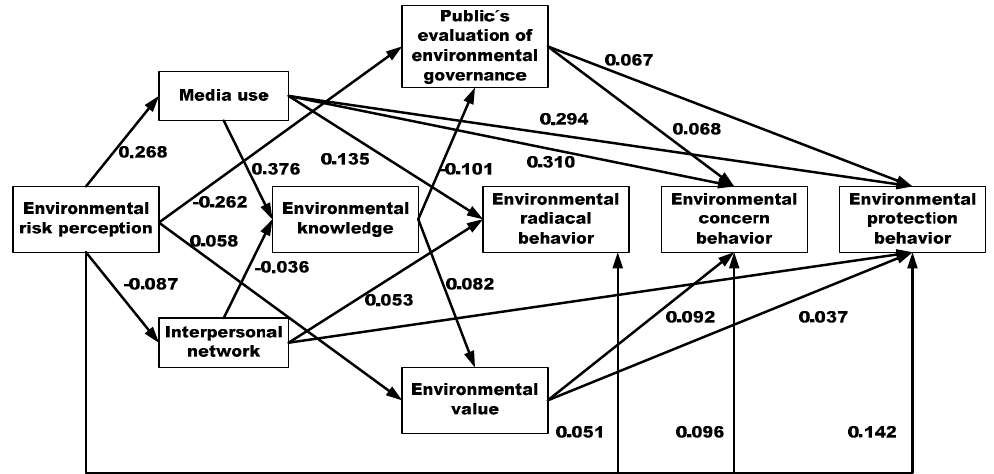
Figure 2. The dynamic evolution progress of environmental behavior.